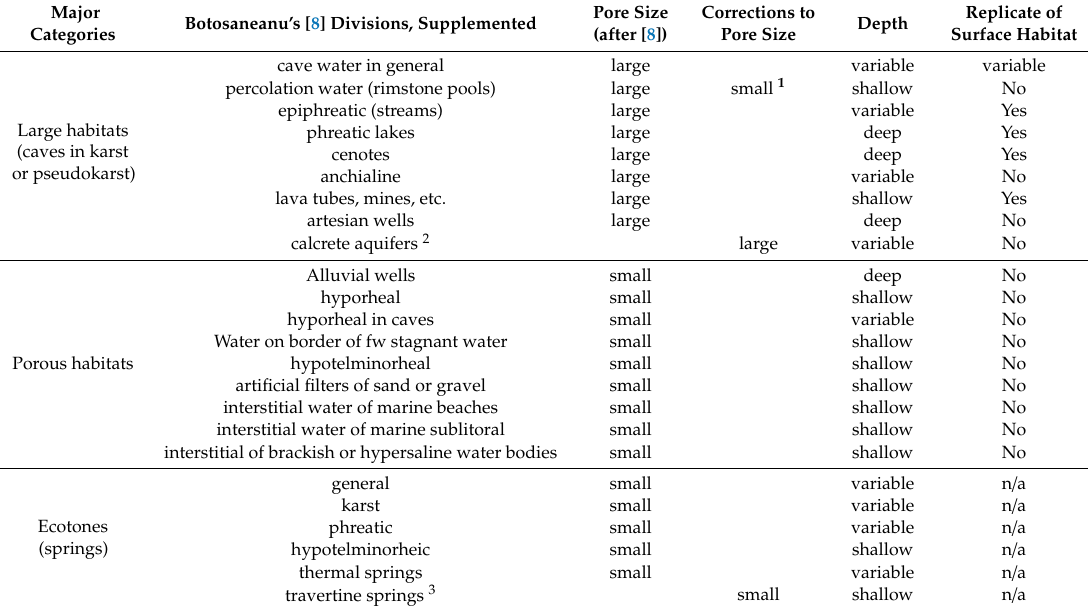
Table 1. Aquatic subterranean habitats: after Botosaneanu [8]—simplified and modified. The shallow / deep dichotomy is based on a diving line at 10 m